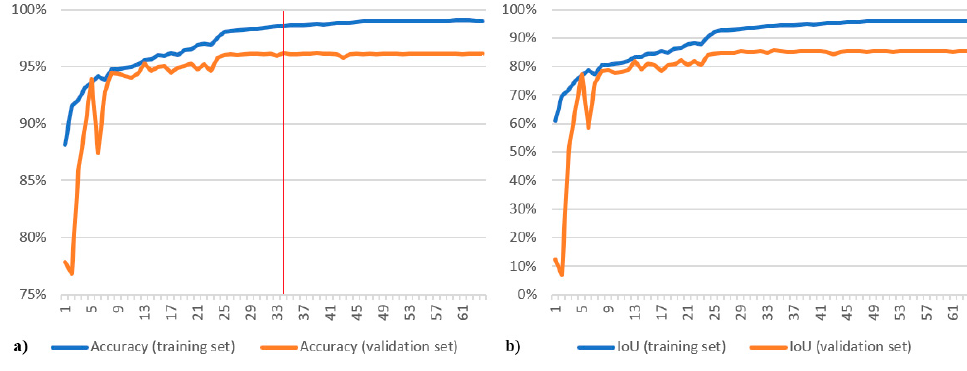
Figure 9. Accuracy ( a ) and IoU ( b ) metrics for the U-Net ( n = 32) model.